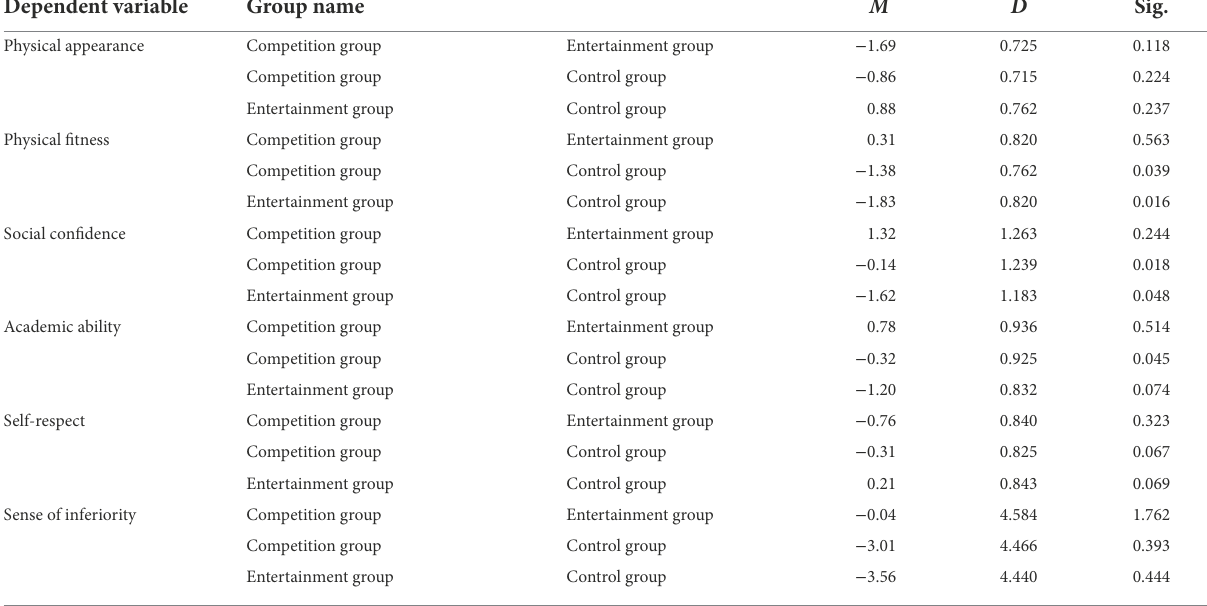
TABLE 6 Inter-group comparison results of multivariate variance analysis on college students’ inferiority feeling under different sports scenarios.